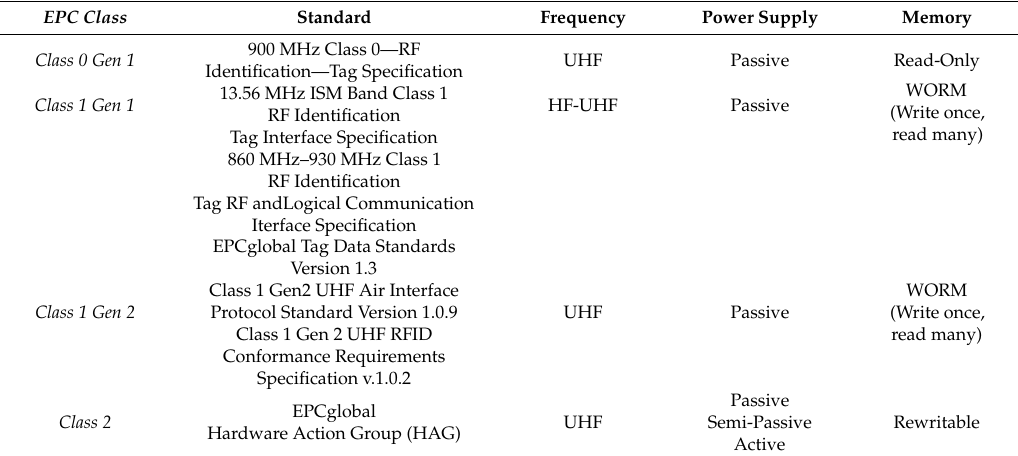
Table 4. RFiD EPC classification.